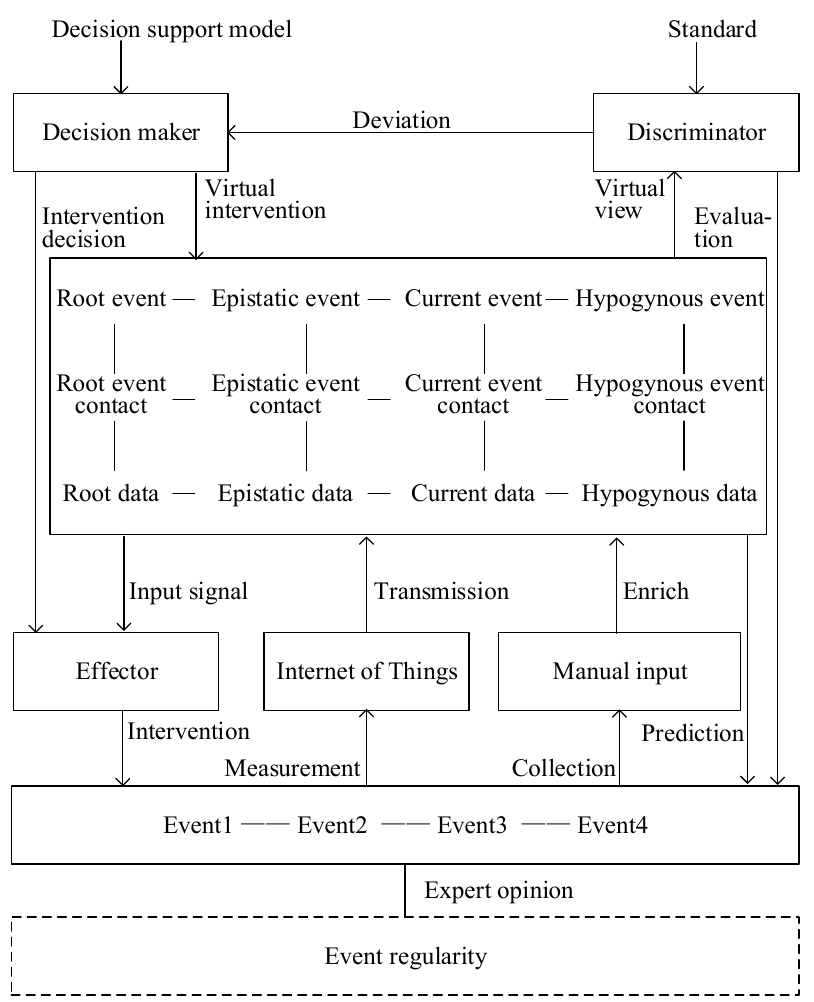
Figure 7. Shili Mirrored Structure based on intelligent technology.